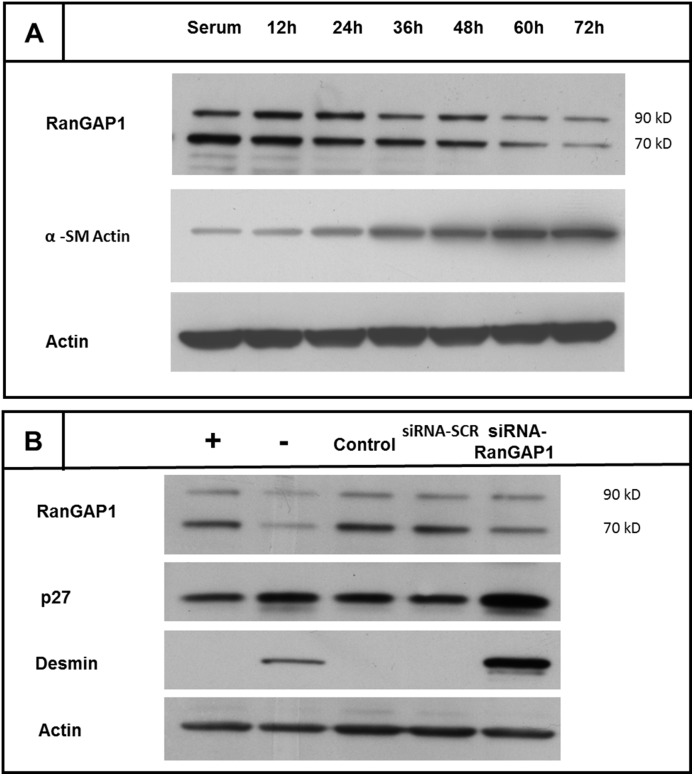
Downregulation of RanGAP1 in arrested, differentiated smooth muscle cells (A).To induce differentiation, CASMCs were depleted from serum. RanGAP1 expression in CASMC was assessed by Western Blotting 12(∼70 kDa) form as well as the SUMO-1 conjugated (∼90 kDa) form of the RanGAP-1 protein. Both bands revealed reduced RanGAP1 expression over time in cells entering quiescence. α-SM Actin protein, a marker of cell differentiation, is increased over time. Actin levels are displayed as loading control. Effect of posttranscriptional gene silencing of RanGAP1 by small interfering RNA (siRNA) on cell cycle and differentiation markers (B). siRNA mediated gene silencing of RanGAP1 was able to reduce the 90 kD band by 31.8±21.2% (90 kD band) and 75%±14.7% (70 kD band) 48 h post transfection, respectively (average of three different experiments). RanGAP1 depletion was associated with a strong increase of p27Kip1 expression by 60±34%. RanGAP1 deficiency was also associated with a sharp increase in desmin expression with levels even higher than in quiescent cells. CASMC denotes coronary artery smooth muscle cells; (+) denotes serum stimulated CASMC; (−) denotes quiescent CASMC (≥72 h serum depletion); “control” denotes oligofectamine transfected cells without siRNAs; siRNA-SCR denotes scrambled (control) siRNA.